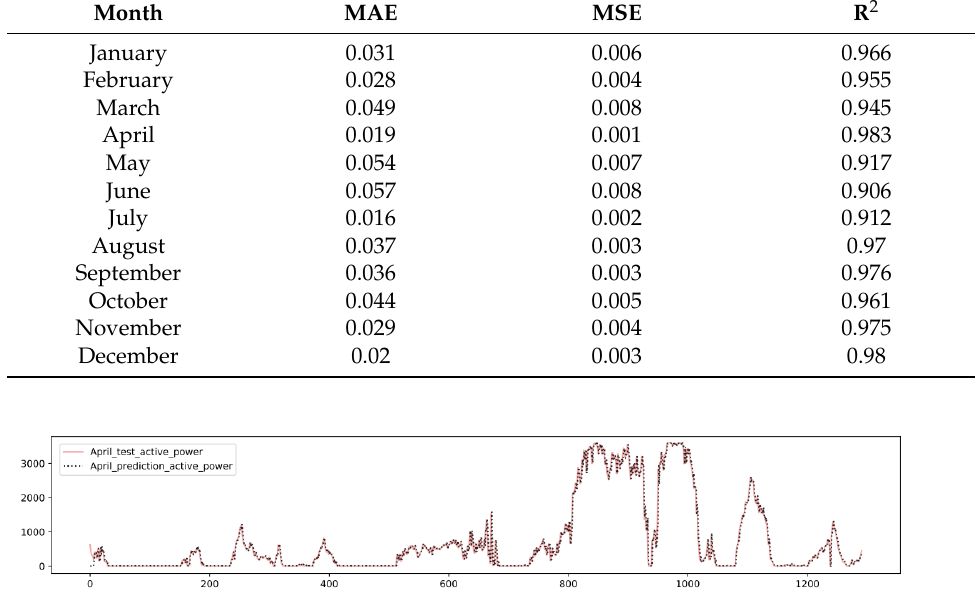
Table 4. The performance measures of active power prediction over the test set for the whole year.